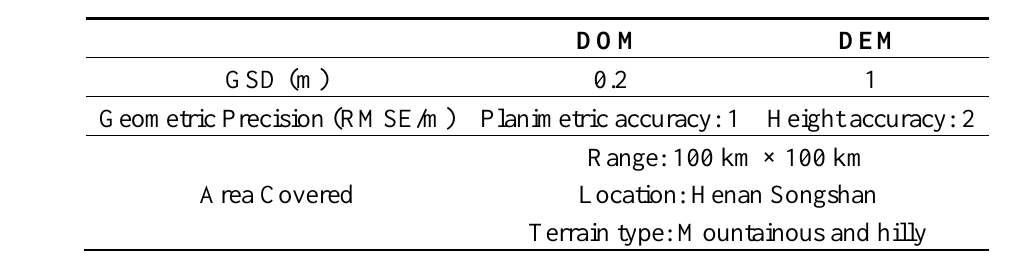
Table 2. Specific information about the reference